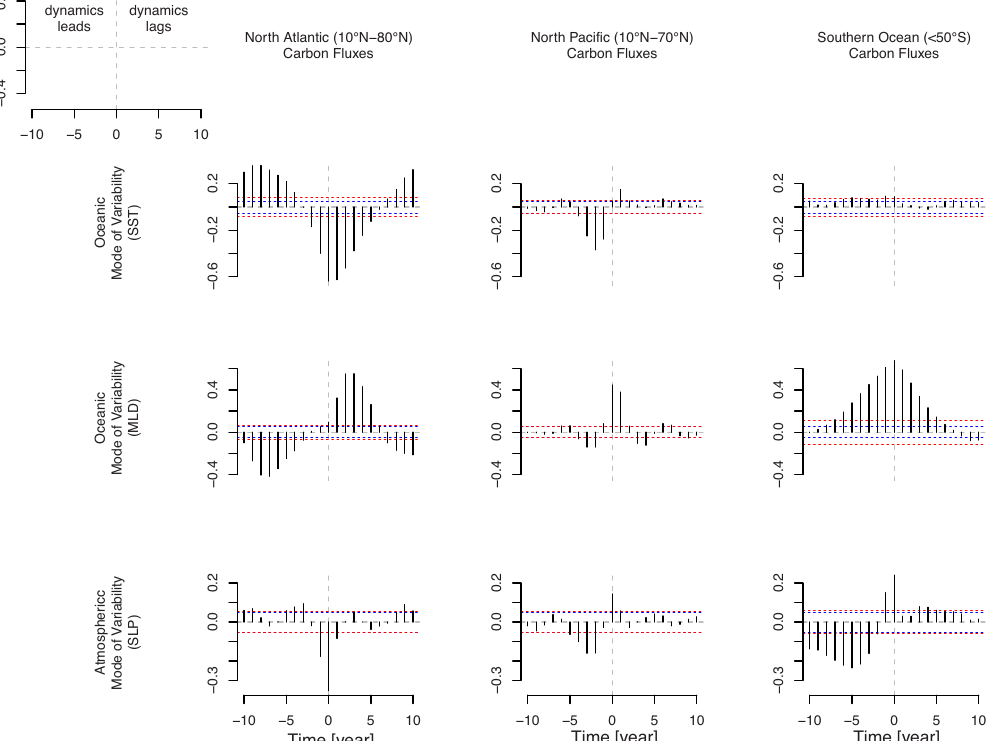
Fig. 8. Lagged correlation of leading principal components of ocean carbon fluxes and sea-surface temperature (SST), mixed-layer depth (MLD) and sea-level pressure (SLP) in the North Atlantic, the North Pacific and the Southern Ocean. Null hypothesis assessed with a t test at 95% of significance are mentioned with dashed blue lines and red lines (following Bretherton et al., 1999).